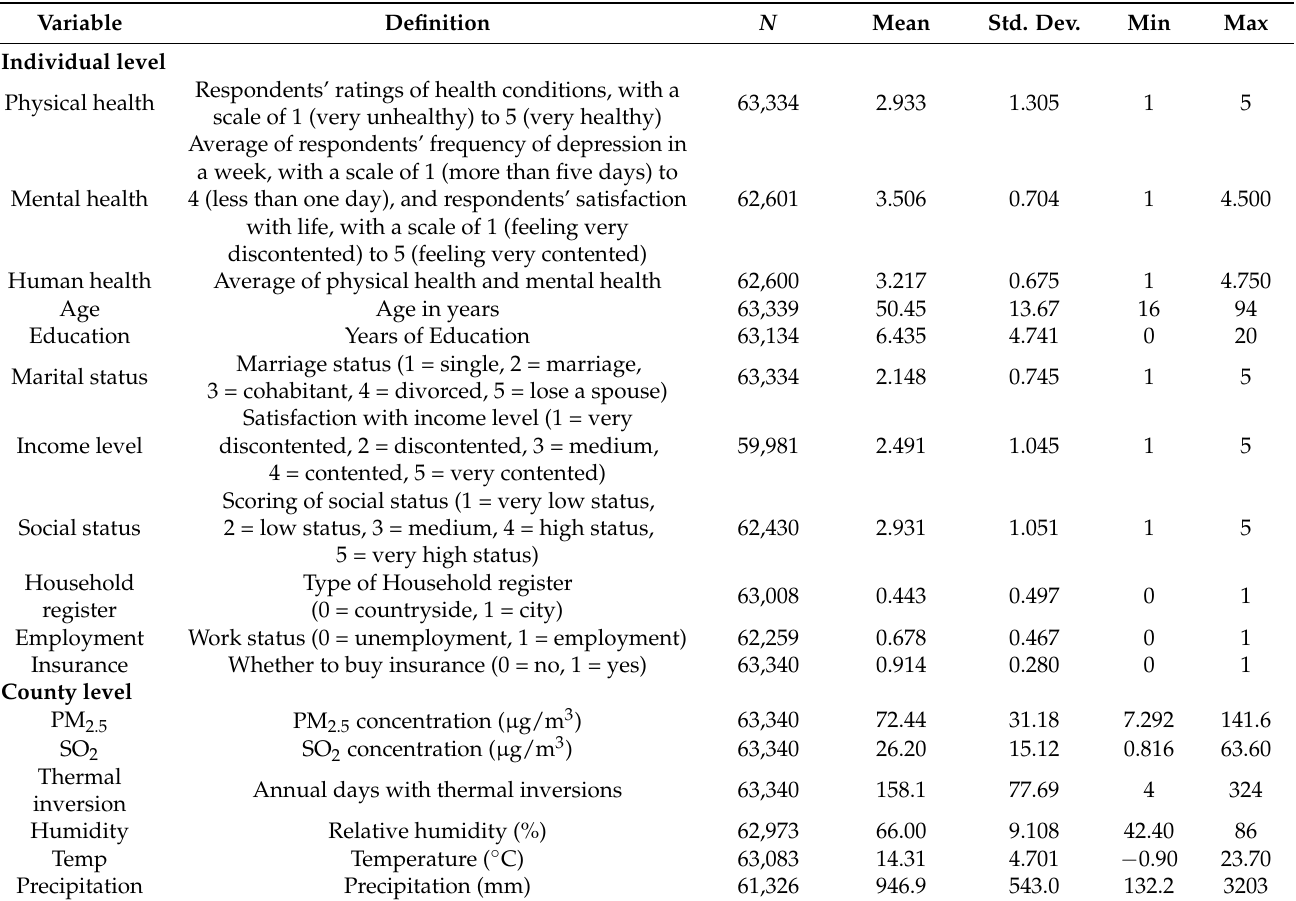
Table 1. Summary